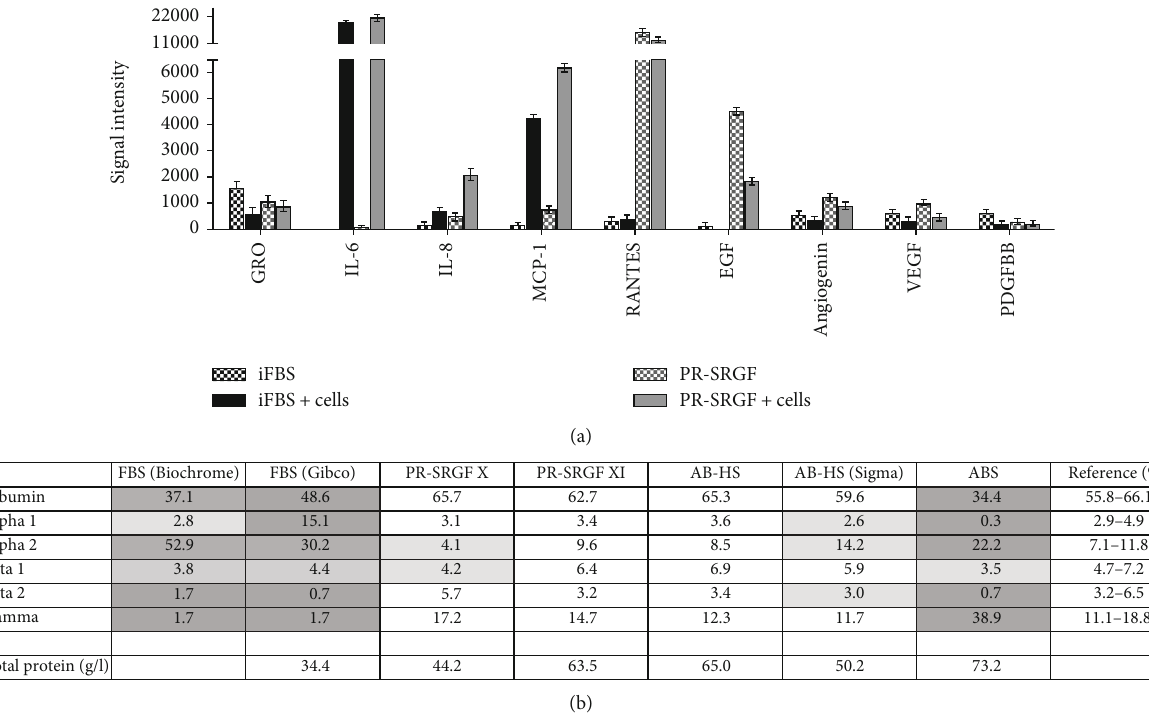
Figure 5: (a) Analysis of selected cytokines in the medium supplemented with 10% iFBS and 7.5% PRSRGF after cultivation with MSC ( iFBS + cells , PR − SRGF + cells ) or without cell cultivation (iFBS, PR-SRGF) after 72 hours. (b) Determination of protein fractions in nondiluted iFBS, PR-SRGF, AB-HS, AB-HS (Sigma), and ABS (adult bovine serum) (without cell cultivation) by capillary ELFO analysis compared to the human reference standard (albumin, alpha-1-globulins, alpha-2-globulins, beta-1-globulins, beta-2-globulins, gamma- globulins). Light grey: out of the reference range; dark grey: extremely out of the reference